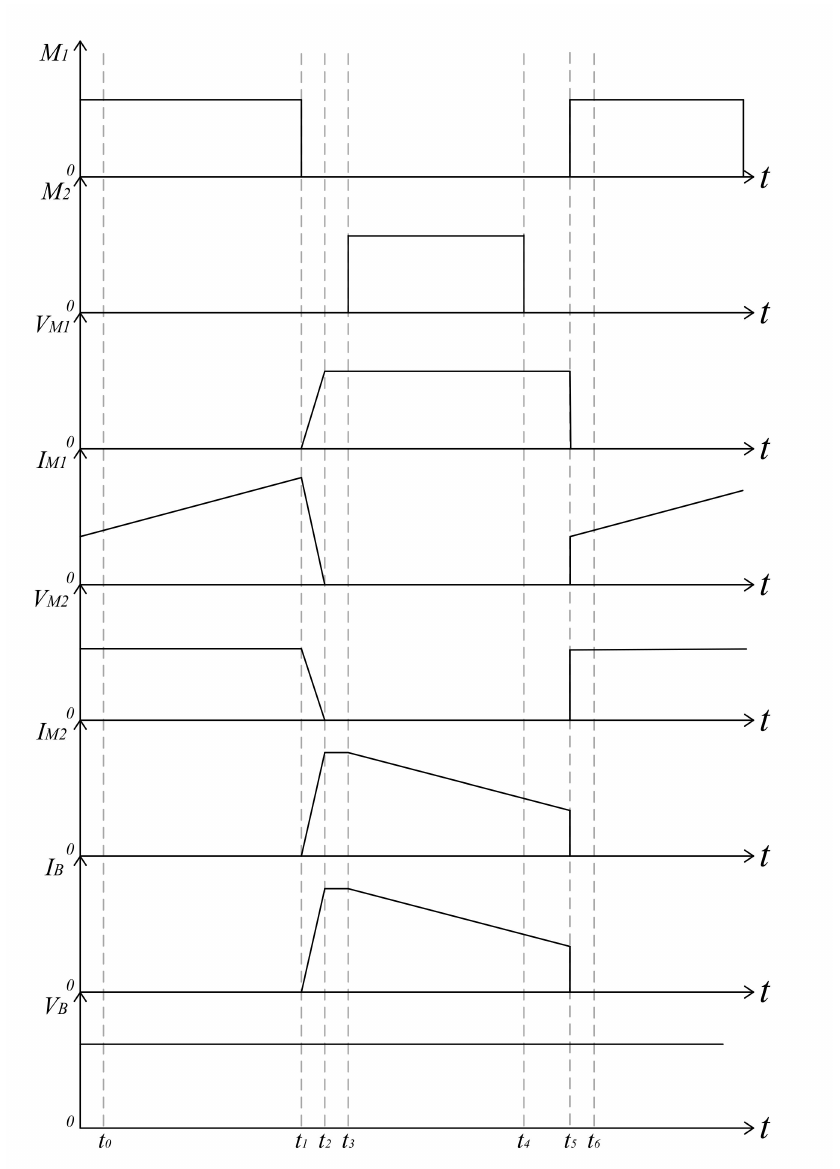
Figure 8. Conceptual waveforms of the propose hybrid converter operated in the charging mode.